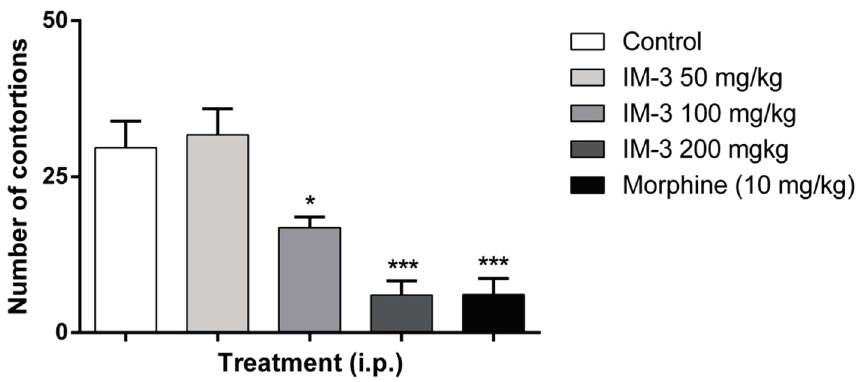
Figure 1. Effect of IM-3 on the latency of the first contortion in the acetic acid-induced writhing test in mice ( n = 8). ANOVA followed by Dunnett’s test. *** p < 0.001.